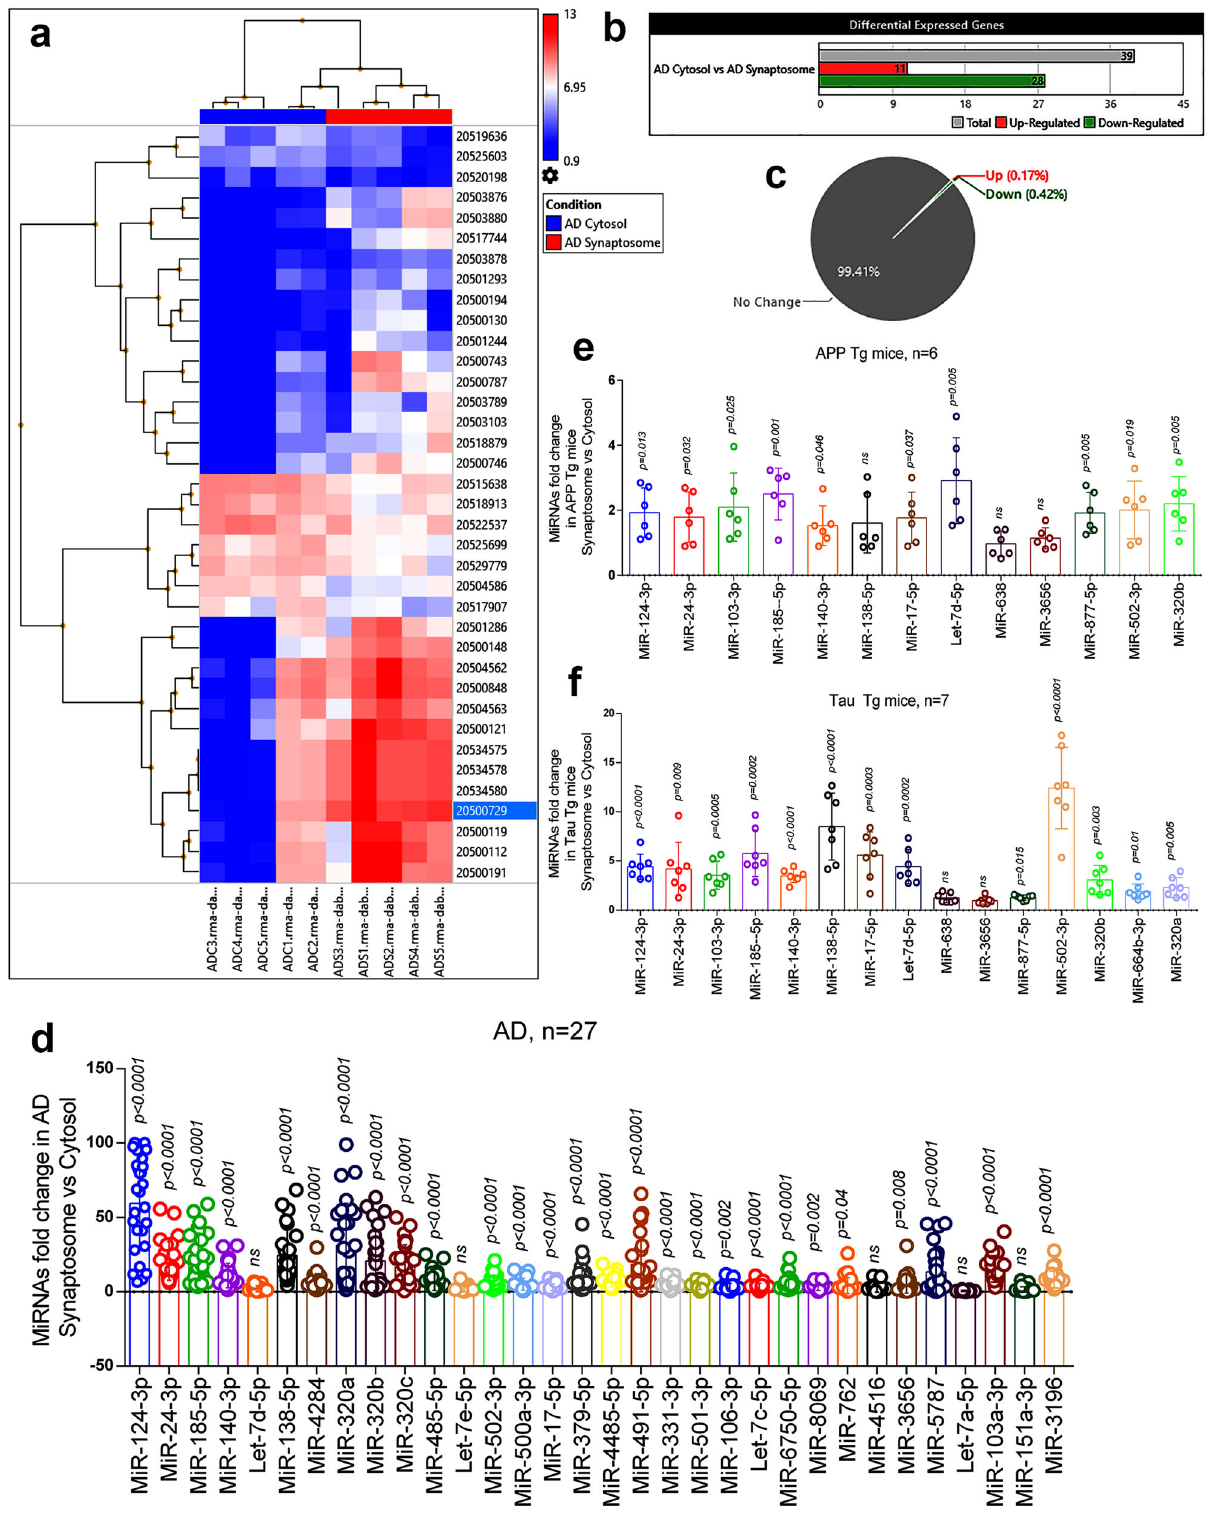
miRNAs, only 33 miRNAs were successfully ampli fi ed by qRT-PCR using speci fi c primers. The 18 miRNAs showed similar expression trends as obtained by Affymetrix data analysis. The remaining miRNAs did not concur with Affymetrix data. Overall, 24 miRNAs were signi fi cantly upregulated in the synaptosomes relative to